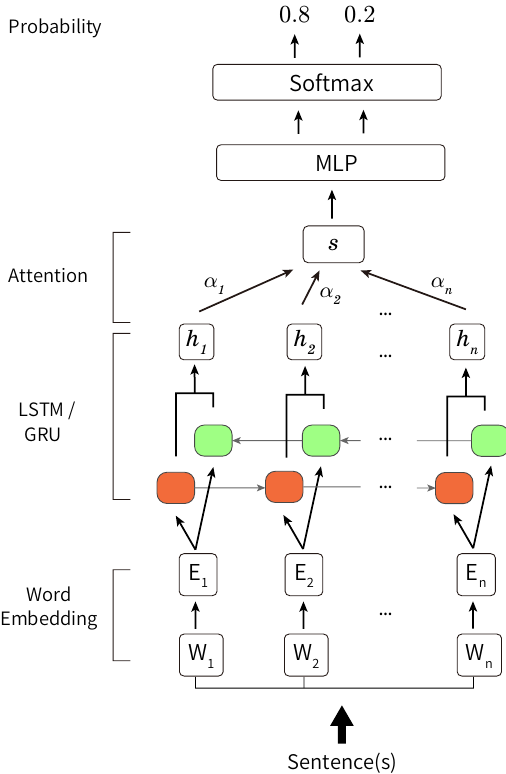
Figure 2. Overview of our method. Sentences are split into words using MeCab. Words are converted to word embeddings using GloVe. We input these word embeddings to bidirectional LSTM or GRU. The outputs of the hidden layers are weighted by the attention mechanism. We input the weighted output to MLP and softmax function. Then, the probability of each label is